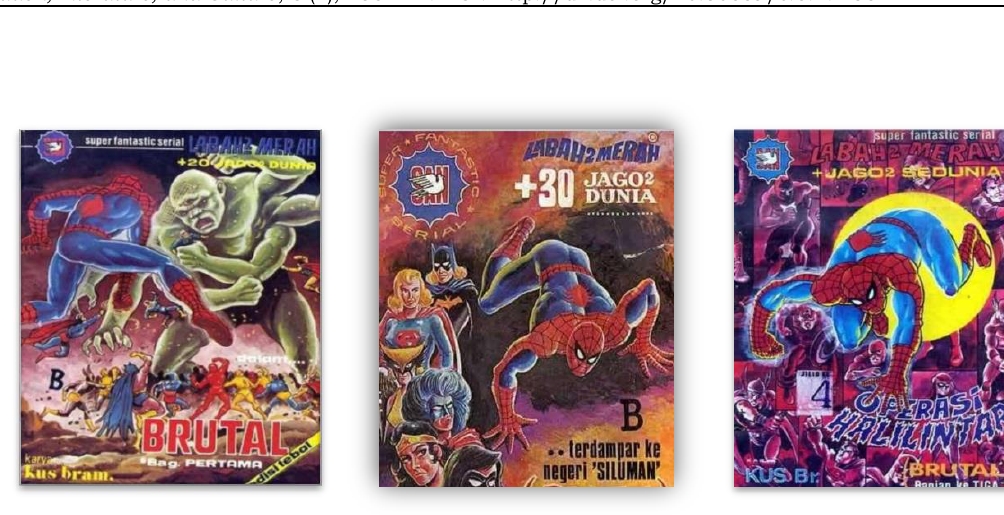
Figure 2: the concept of original, borrow and traditions of Labah-Labah Merah by Kus Bram in the 1969s which is inspired by Spiderman from Marvel